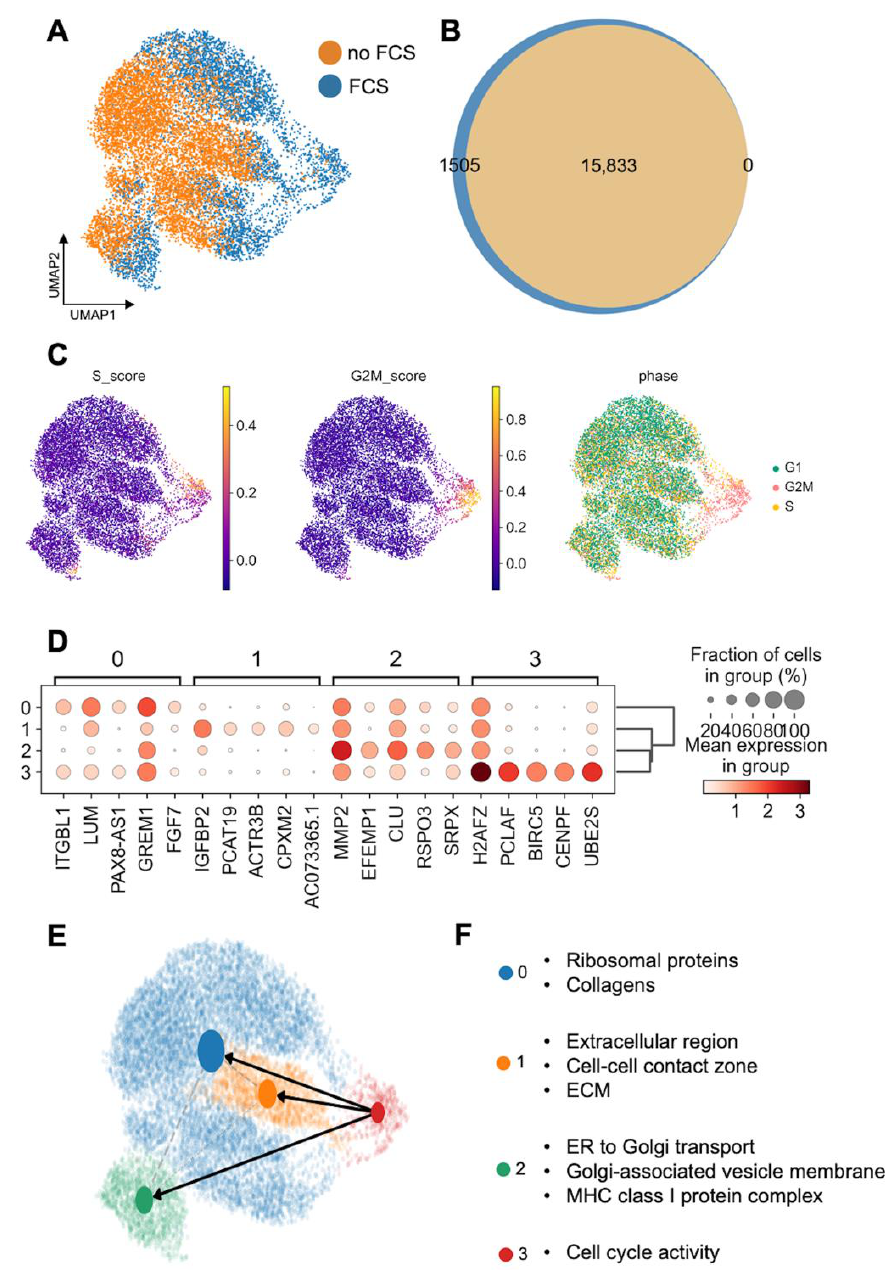
Figure 2. ( A ): UMAP plot of samples derived from HTPC-1 with and without FCS. ( B ): Venn diagram indicates overlap of both of the samples. The exposure of HTPCs to FCS results in the expression of 1505 additional genes. ( C ): Cell cycle stages [31] display one distinct proliferating cluster in the FCS sample. ( D – F ): Four distinct states of cellular differentiation were observed, indicating plasticity and proliferation. ( D ) Dot plot demonstrates expression of most abundant genes in each cluster. ( E ) Velocity analysis was embedded into the PAGA graph, which indicates trajectory of the proliferating cluster into three functional subgroups. ( F ) Representative GO terms after string analysis with upregulated genes.